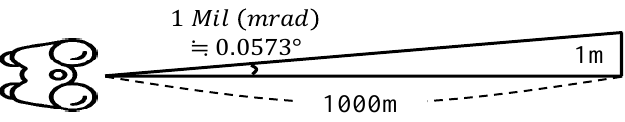
Figure 5. Milliradian measurement using observation